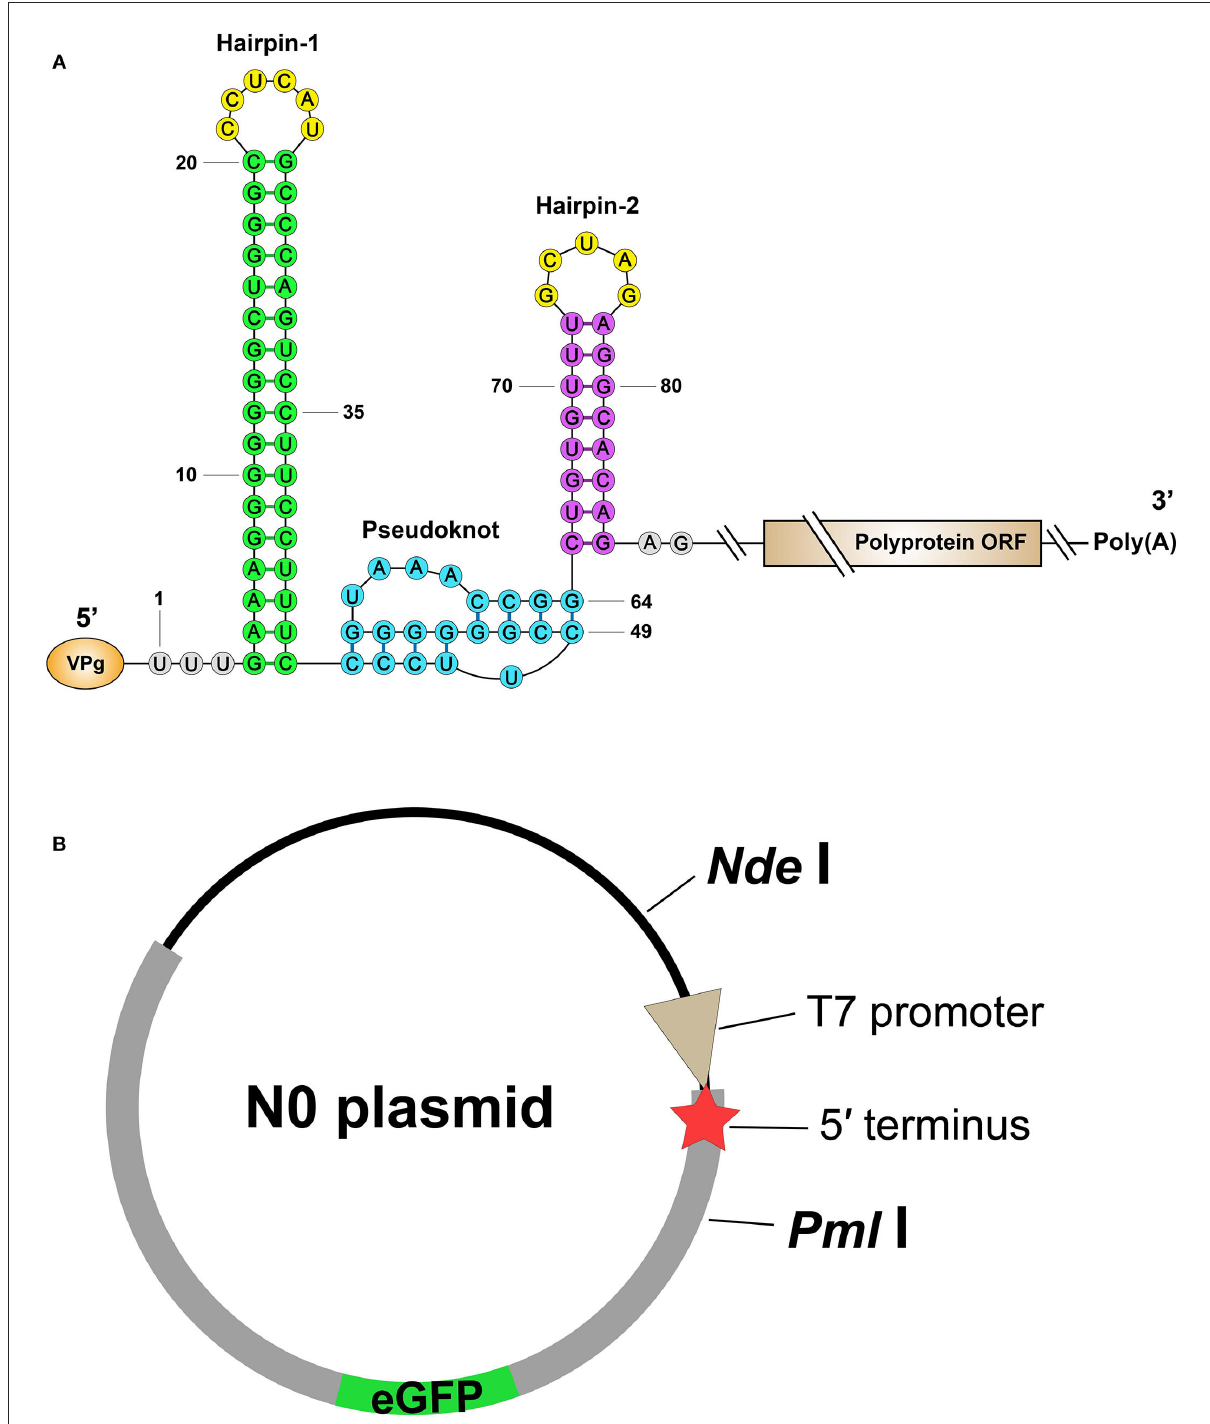
FIGURE1 Schematic representations of putative HPH structure and wild-type cDNA clone. The HPH formation (A) is predicted through two online servers. The first hairpin, hairpin-1, is made up of one 17-nt-paired stem and one 6-nt-unpaired loop (Green stem-Yellow loop); the middle structure is an H-type pseudoknot, containing two stems and two loops (Blue stem-Blue loop); the second hairpin, hairpin-2 (Purple stem-Yellow loop), is structurally simpler than the hairpin-1. The N0 plasmid contains the wild-type SVA cDNA clone with a fusion sequence of eGFP- Thosea asigna virus 2A (B) . The red star indicates the 5 ′ terminus of cDNA